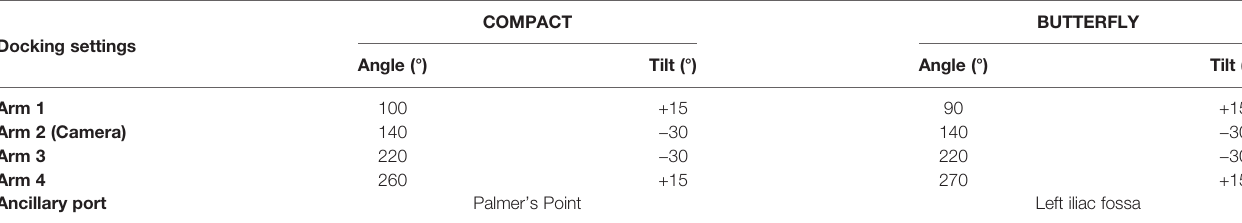
TABLE 1 | Main docking setting variables for both con fi